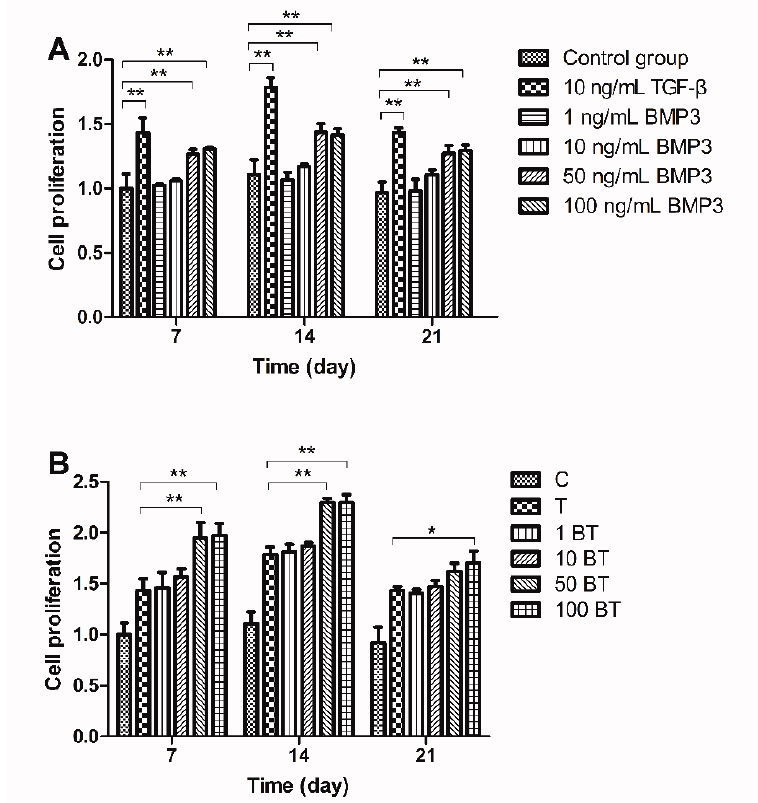
Figure 1. Effect of TGF- β , BMP3 and different gradients of BMP3/TGF- β on cell proliferation on days 7, 14, and 21. ( A ) Effect of 10 ng/mL TGF- β and different gradients of BMP3 on mesenchymal stem cells (MSCs) proliferation and ( B ) Effect of different gradients of BMP3/TGF- β on MSCs proliferation. C = control; T = 10 ng/mL TGF- β ; 1 BT = 1 ng/mL BMP3/10 ng/mL TGF- β ; 10 BT = 10 ng/mL BMP3/10 ng/mL TGF- β ; 50 BT = 50 ng/mL BMP3/10 ng/mL TGF- β ; 100 BT = 100 ng/mL BMP3/10 ng/mL TGF- β . Data represent mean ± SD; * p < 0.05, ** p <